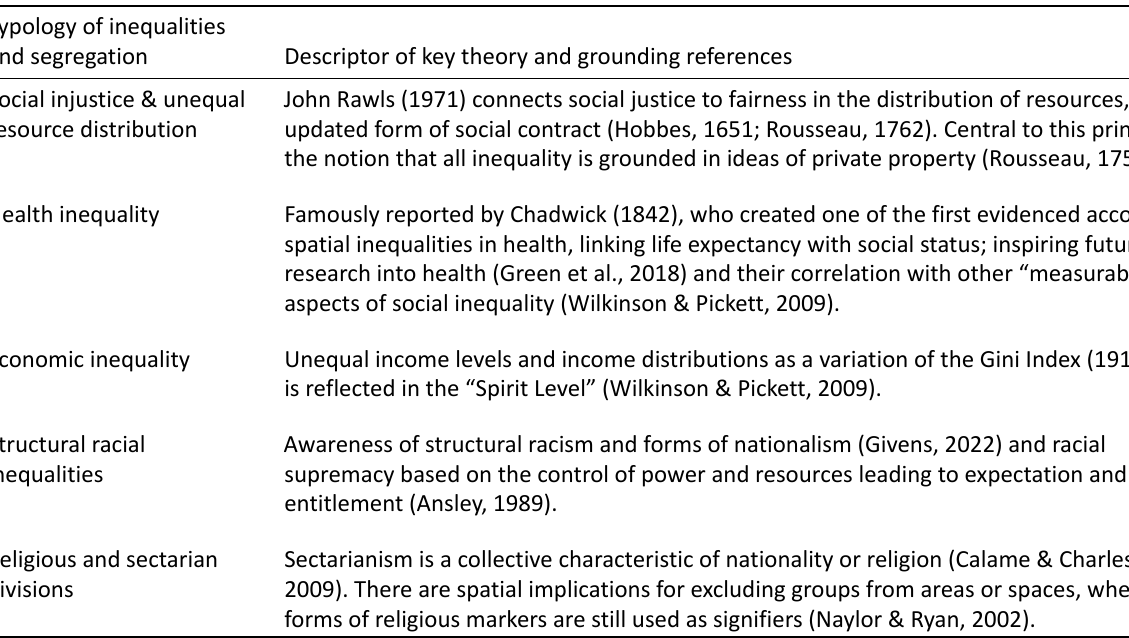
Table 1. Mapping the typologies of inequalities and